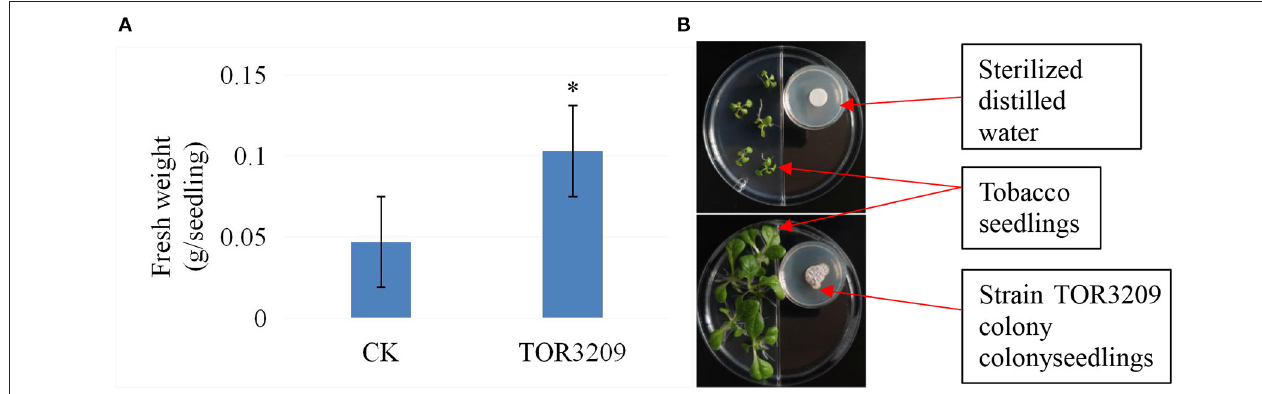
FIGURE 1 | Comparison of effects of strain TOR3209 VOCs on tobacco growth. (A) Comparison of fresh weight between the CK seedlings and treatment seedlings; (B) Photographs showing the growth promotion on growth of tomato seedlings by strain TOR3209 co-culture (bellow) in comparison with CK control (upper). * The same letter followed the values in the same column means no significant difference based on the least significant difference (LSD) test ( p < 0.05).